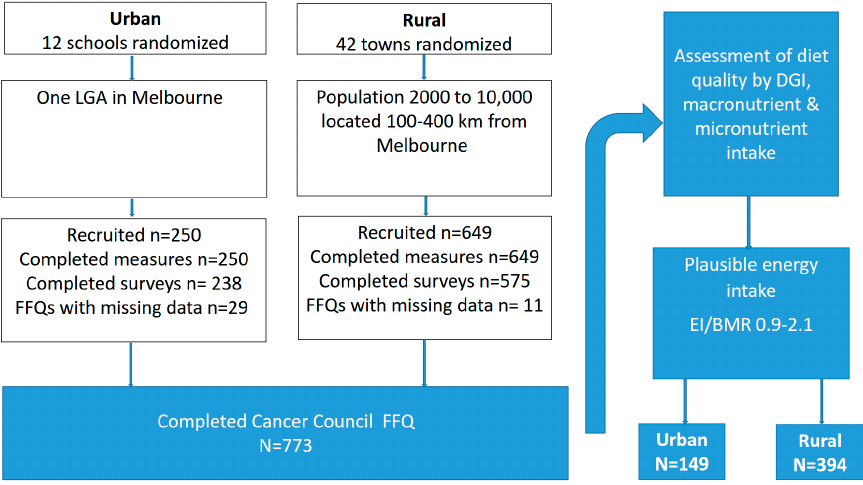
Figure 1. Flow chart of participants in the final analysis. Table 2. Baseline demographic characteristics of urban and rural women.